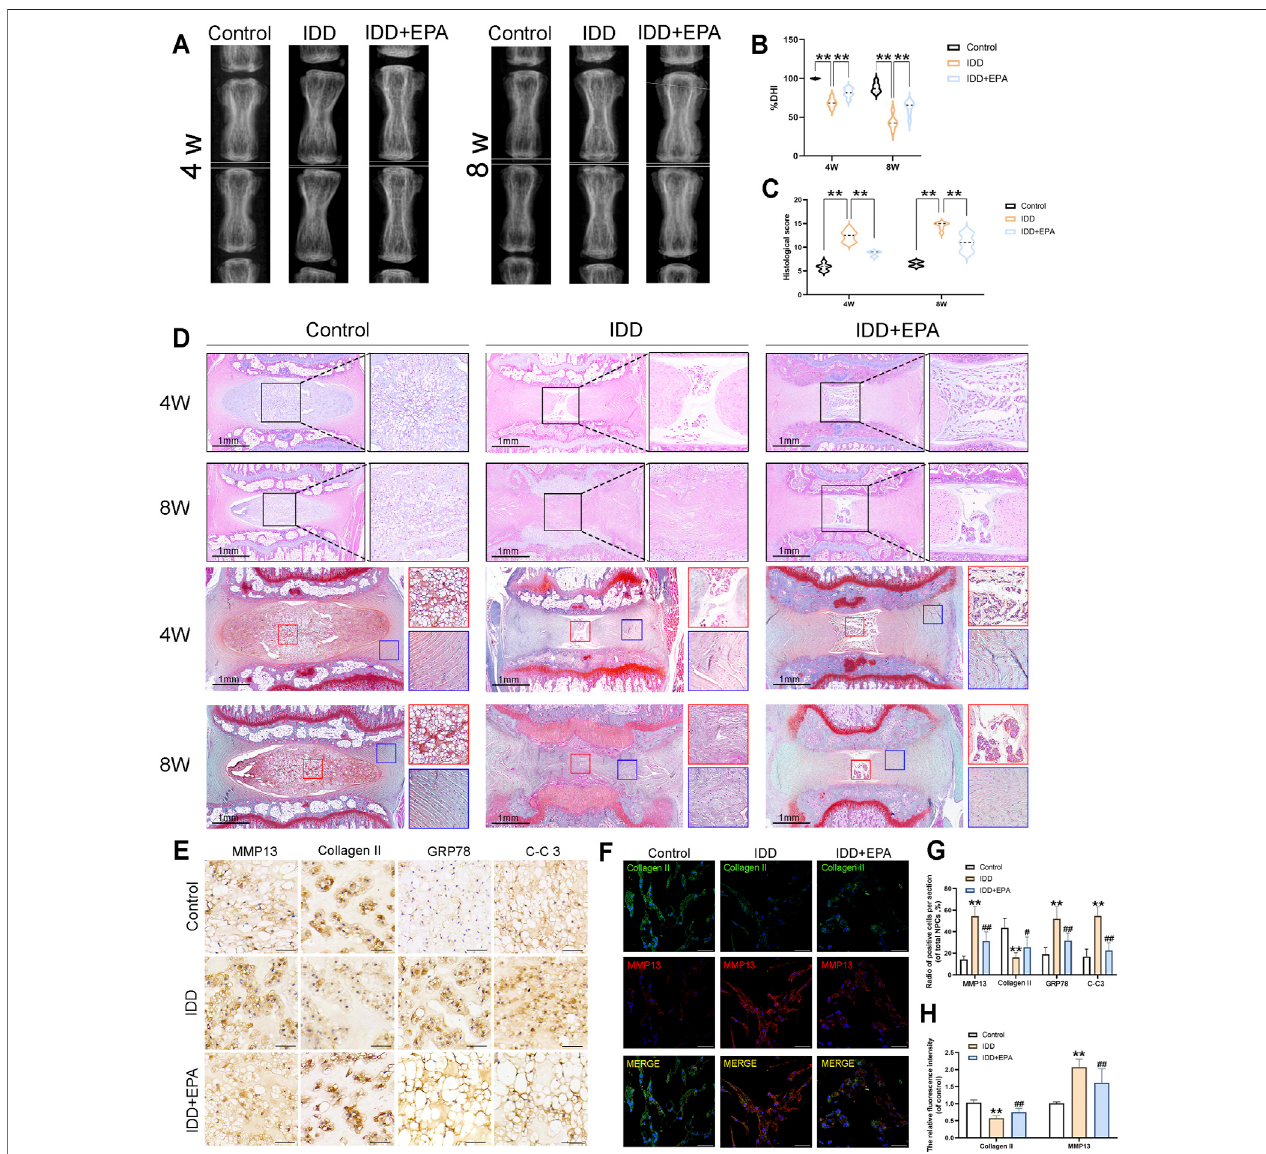
FIGURE 7 | EPA can play a protective role in the in vivo model of rat IDD. (A,B) The representative X-ray images and disc height index (DHI) analysis of the rat-tail discs at 4 and 8 weeks after disc surgery (white line: height index of the surgical discs). (C,D) Representative HE staining of disc tissues from three groups at 4 and 8 weeks post-surgery (scale bar: 1 mm, n (cid:2) 6). (C,D) Representative SO staining of NP tissues and AF tissues from three groups at 4 and 8 weeks post-surgery (scale bar: 1 mm, n (cid:2) 6). The histological scores evaluated at 4 and 8 weeks post-surgery in three groups. (E,G) Immunohistochemical staining assay of MMP13, Collagen II, GRP78 and C-C3 in intervertebral disc in rats (scale bar: 25 μ m, n (cid:2) 3). (F,H) Immuno fl uorescence staining assay of Collagen II and MMP13 in intervertebral disc in rats (scale bar: 100 μ m, n (cid:2) 3). All data represent mean ± S.D. * p < 0.05, ** p < 0.01, compared with the control group.